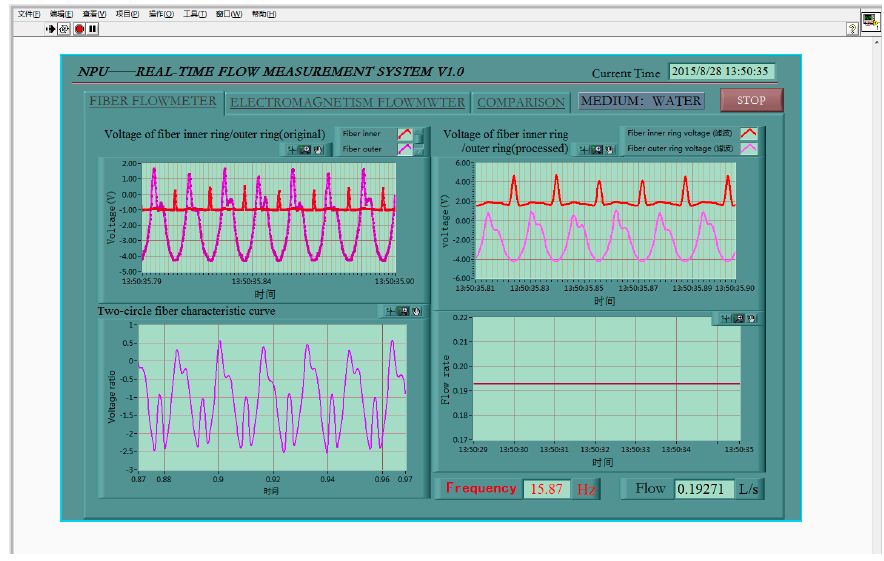
Figure 10. Test display interface of fiber turbine flow sensor in the nonlinear range.